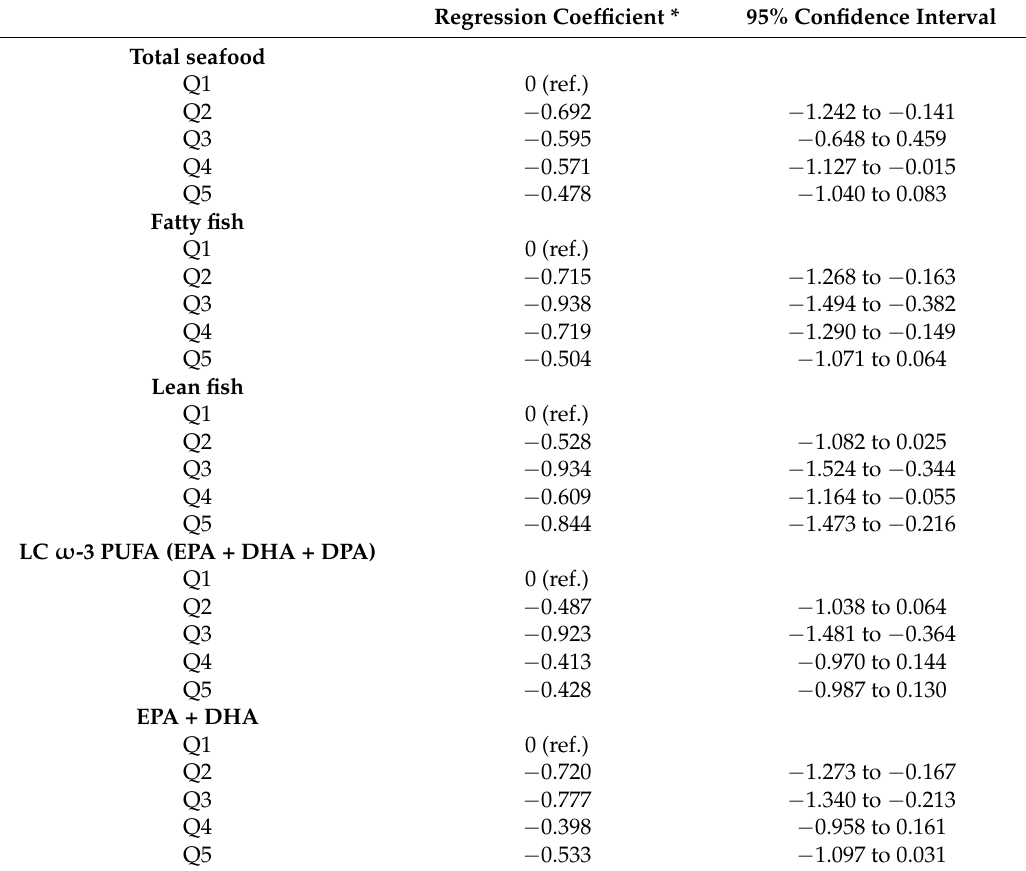
Table 4. Scores in the Beck Depression Inventory-II according to quintiles of consumption of fish/seafood or long-chain omega-3 fatty acids in the PREDIMED-Plus trial. Regression Coefficient * 95% Confidence